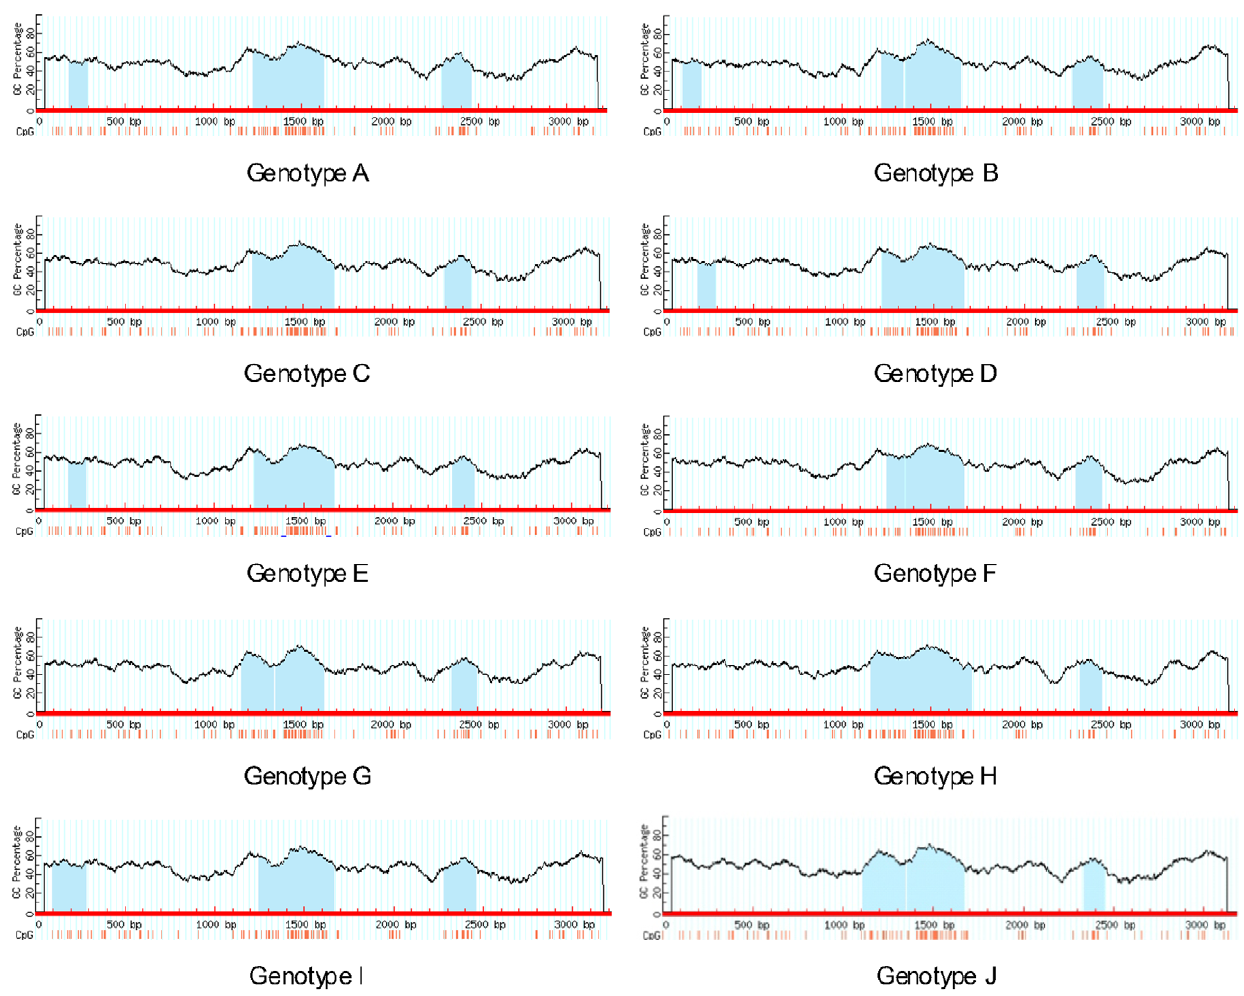
Figure 1. The CpG island distribution within representative HBV sequences of HBV genotypes A–J. The vertical axis refers to the GC percentage, while the horizontal axis refers to the HBV nucleotide sequence. The blue areas represent CpG islands I, II, and III. The vertical red lines indicate CpG dinucleotides.